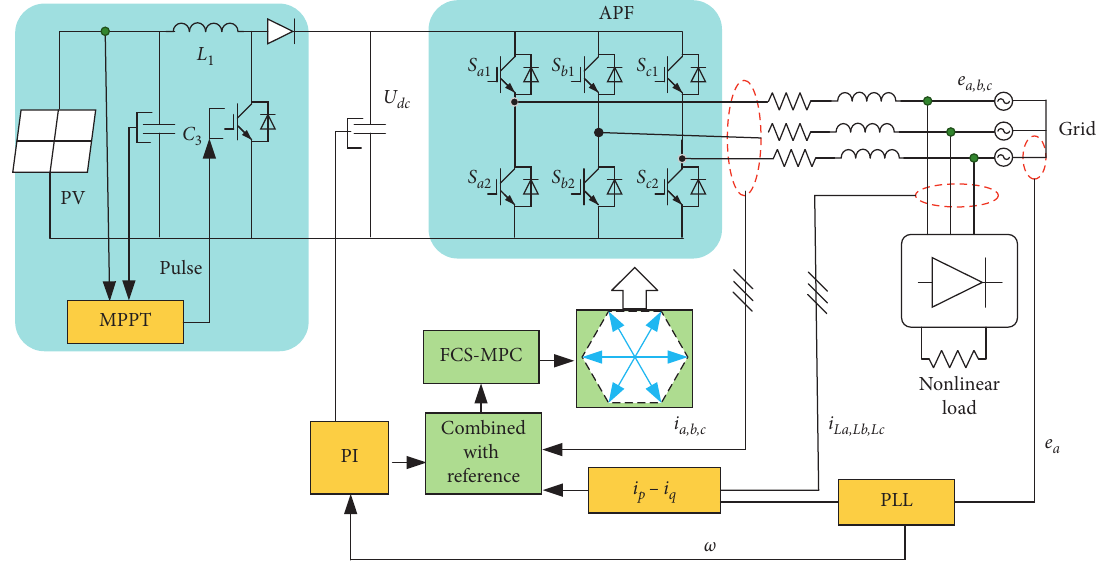
Figure 4: Predictive control of PV